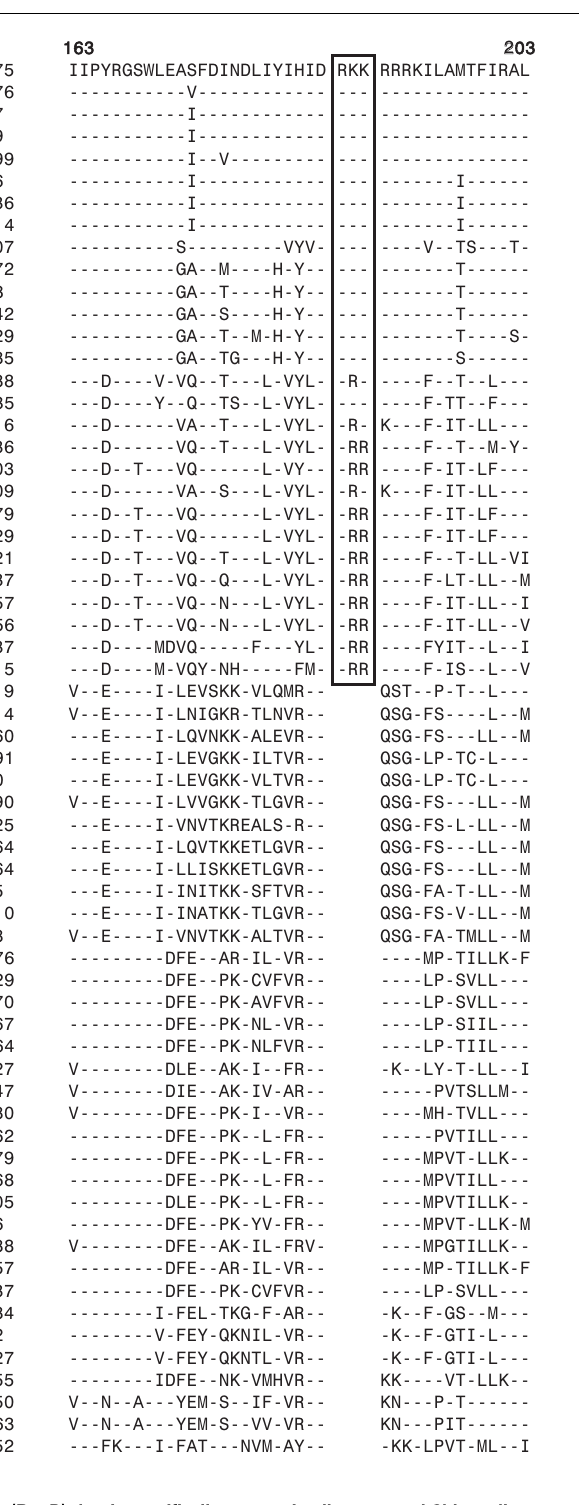
FIGURE 5 |A 3 aa insert in a conserved region of the RNA Polymerase β subunit (RpoB) that is specifically present in all sequenced Chlamydiae, Verrucomicrobia, and Lentisphaera species, but not found in Planctomycetes or any other phyla of